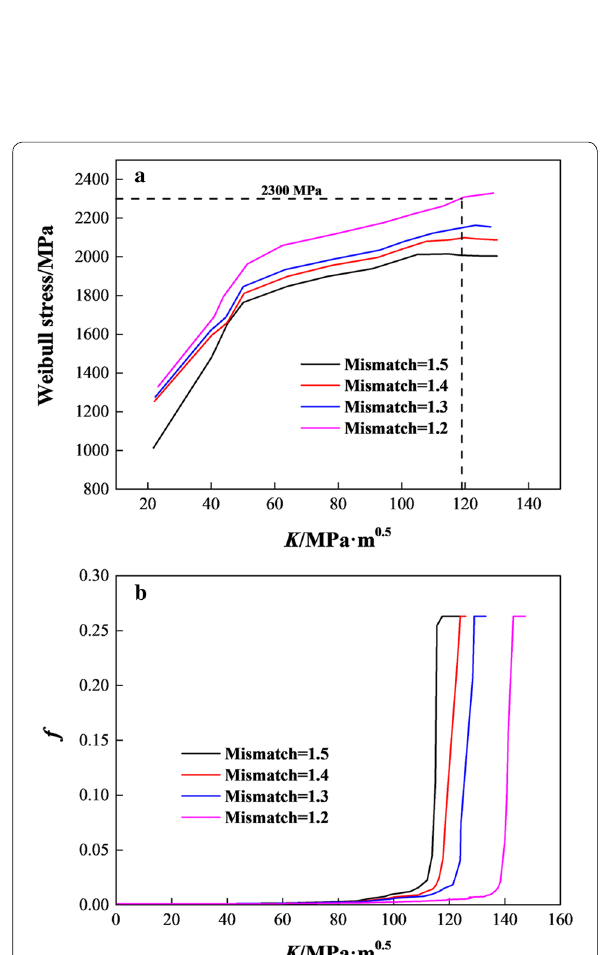
Figure 8 Development of Weibull stress in HAZ2 and cavity volume fraction ( f ) in WM for crack at WM/HAZ2 interface: a Weibull stress in HAZ2; b Cavity volume fraction in